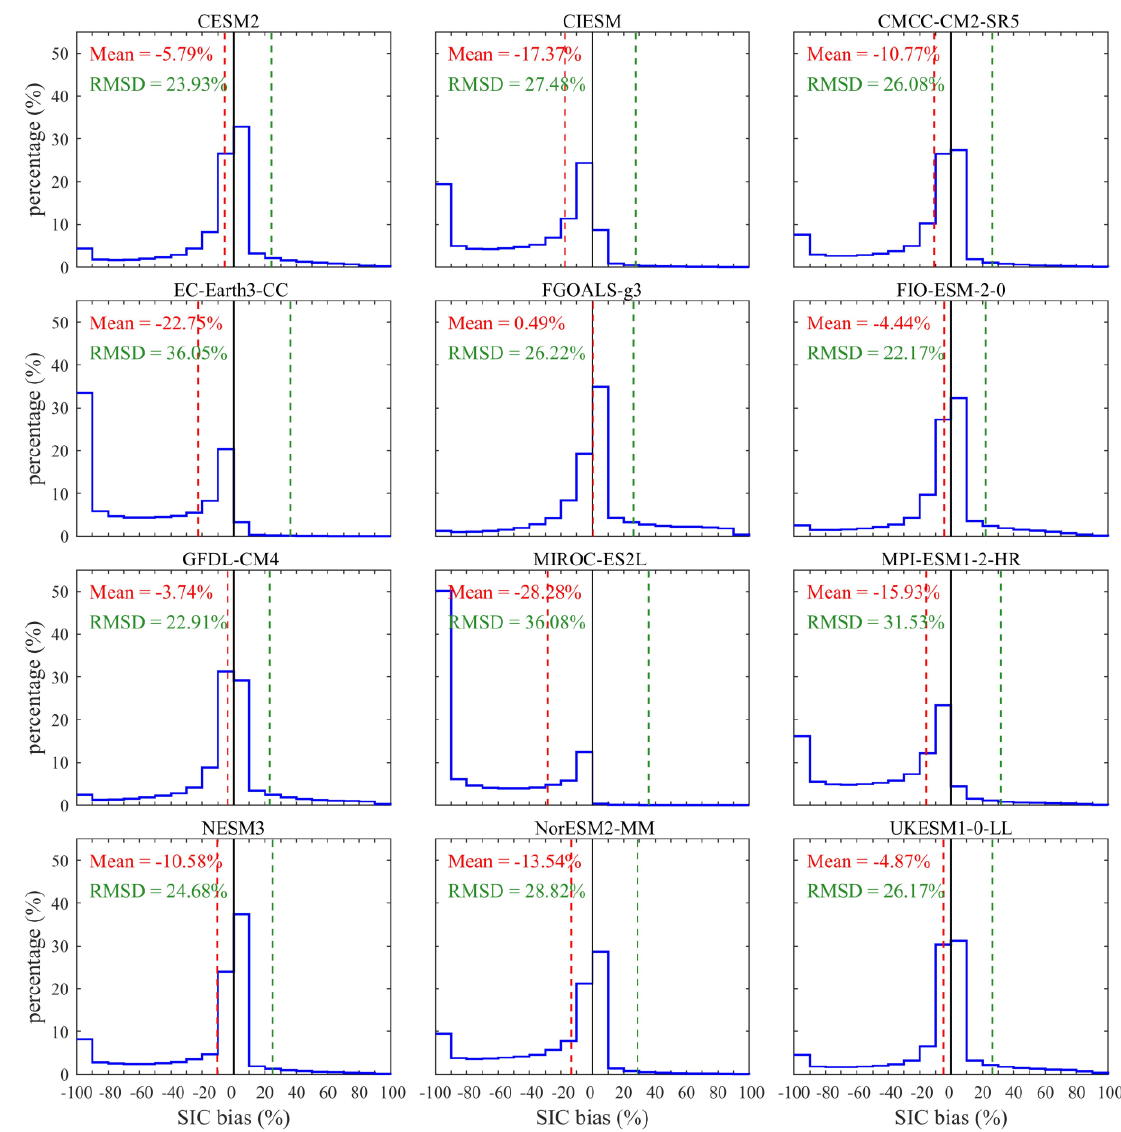
Figure 11. Percentage of SIC biases between the CMIP6 models and the observation for all the data points over the period 2015–2021. The solid black line indicates the boundary between negative and positive SIC bias. The red dashed line indicates the mean bias and the green dashed line indicates the RMSD.